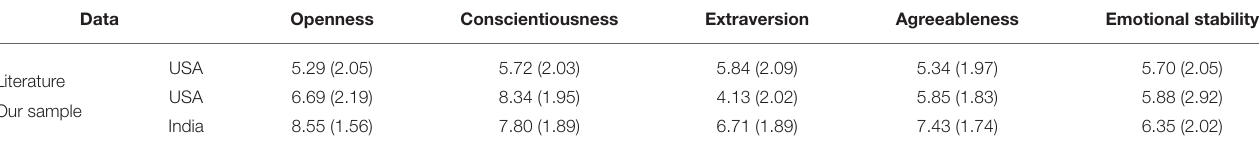
TABLE 12 | Mean and standard deviation of the Big Five personality traits in the literature (Bartram, 2013) and in our sample